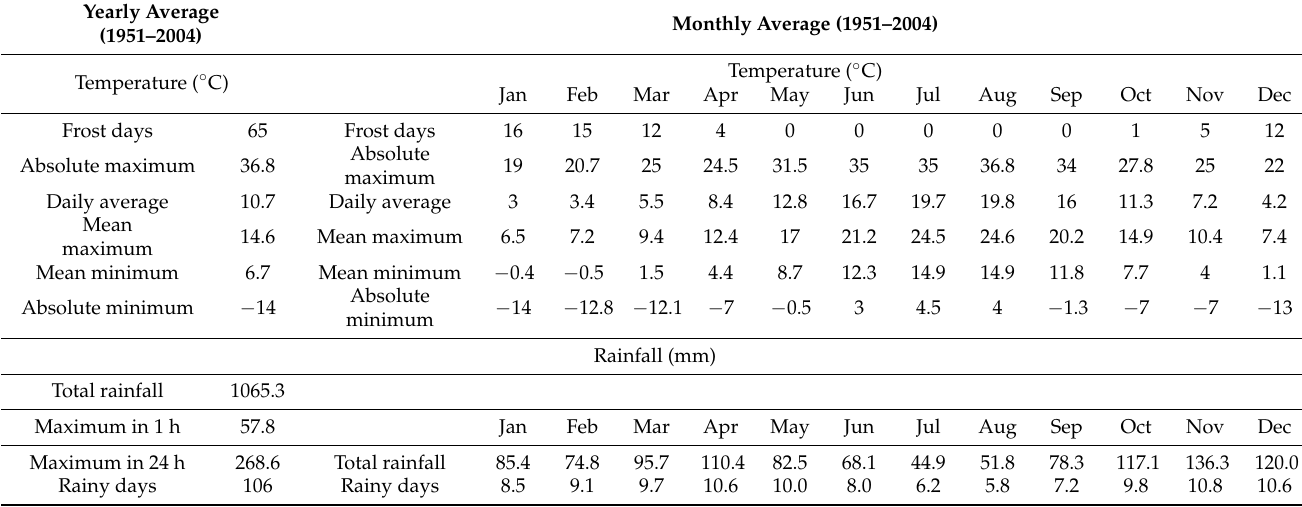
Table 2. Main values of the temperature and rainfall, resulting from the climatic analysis at the Pietracamela gauge (1043 m